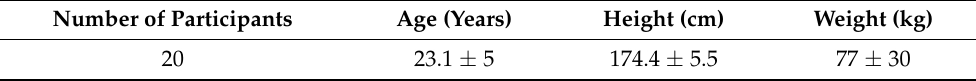
Table 2. Average age and physical information of the